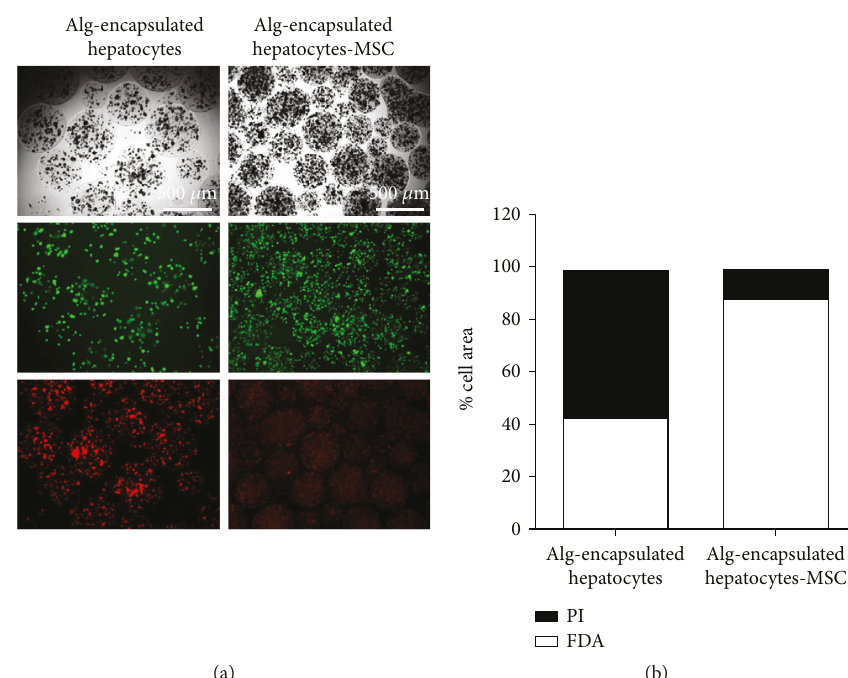
Figure 6: Viability of coencapsulated hepatocytes and MSC. (a) Representative images of Alg-encapsulated hepatocytes alone or with MSC after 4 days of culture. Upper panels present bright- fi eld images, middle panels present viable cells (FDA staining), and lower panels present nonviable cells (PI staining). (b) Quanti fi cation at day 3. Values are expressed as % of the total cell area ( n = 2 ). Quanti fi cation has been performed using